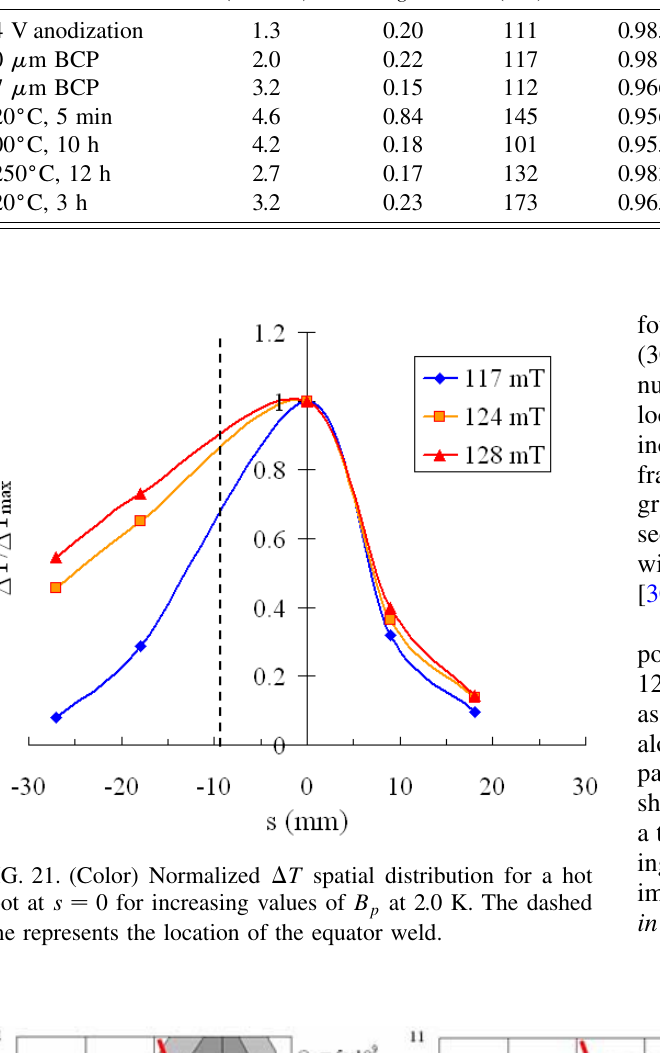
at 2.0 K. The dashed p